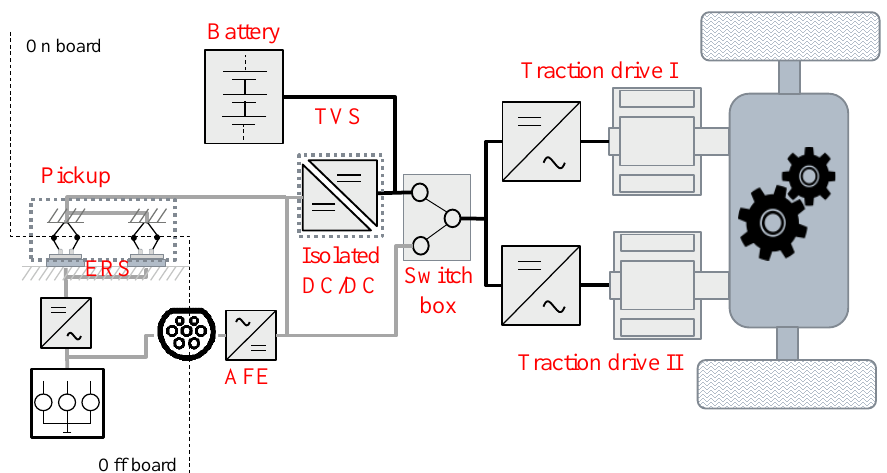
Figure 4. Schematic view of a powertrain; a low-power, isolated DC/DC converter; and a switch box (LSETS). The thick dashed line indicates where an extra layer of isolation towards the vehicle chassis must be